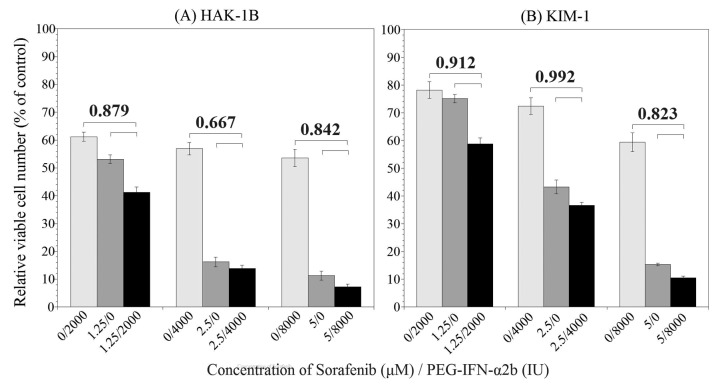
Effect of PEG-IFN-α2b and/or sorafenib on the proliferation of human HCC cell lines (A) HAK-1B and (B) KIM-1 in culture for 72 hours. Light gray bars are PEG-IFN-α2b alone group, dark gray bars sorafenib alone group, and black bars PEG-IFN-α2b + sorafenib group. All combination groups showed significant difference compared with monotherapy groups. The numbers above bars are CI. A CI of 0.9–1.1 indicates a nearly additive effect, a CI of <0.9 a synergistic effect, a CI of >1.1 an antagonistic effect. Representative data of two independent experiments are shown. The values represent mean ± SD.